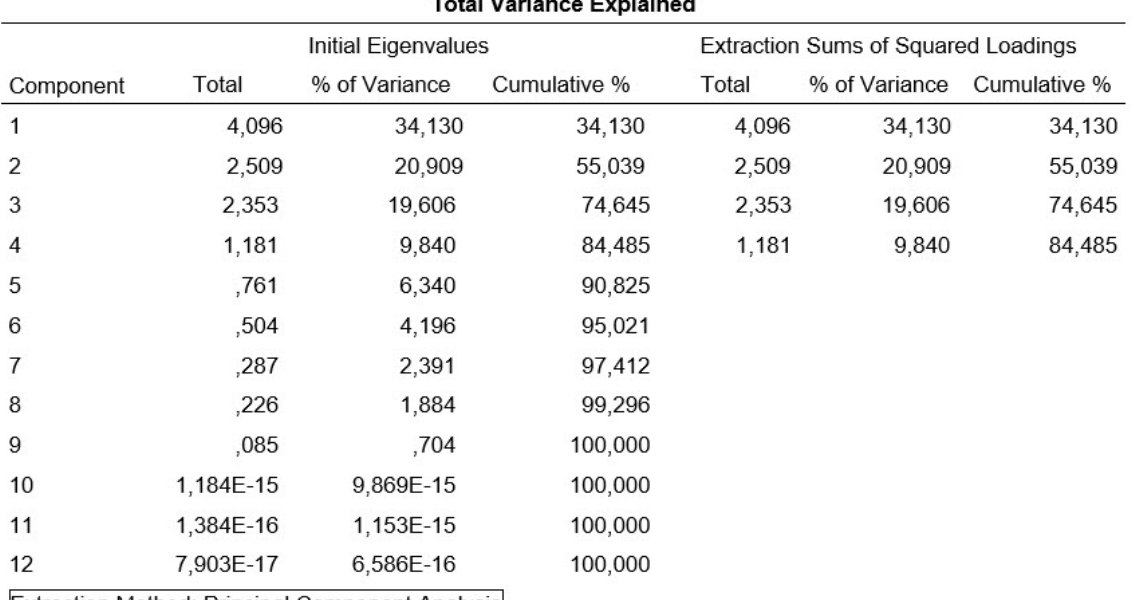
Total Variance Explained for Group